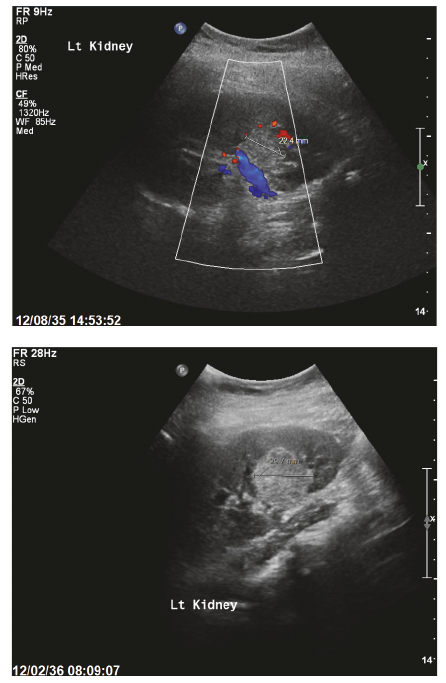
Figure 2: Ultrasound